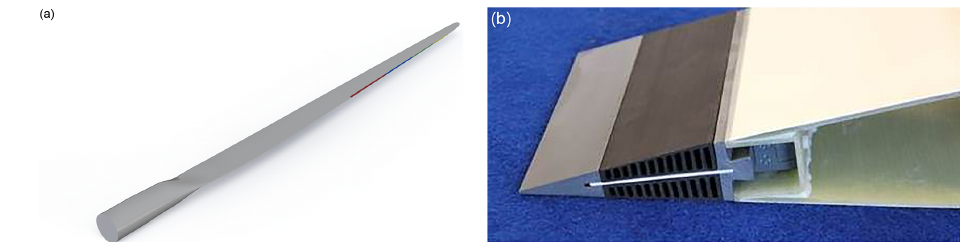
Figure 1. Active flaps on a wind turbine